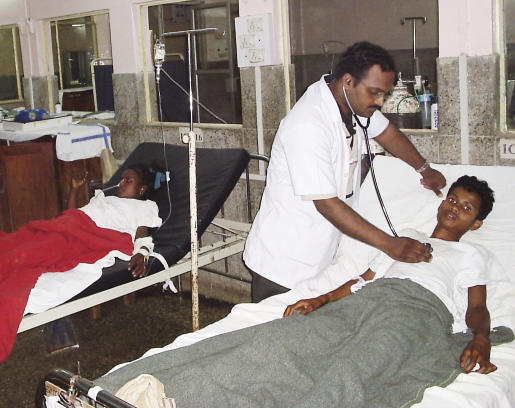
A Young Medical Trainee Examines a Patient with Pulmonary TB at a Rural Hospital in IndiaIn such low-income countries, more years of clinical training and greater exposure to TB patients are important risk factors for acquiring new TB infection.